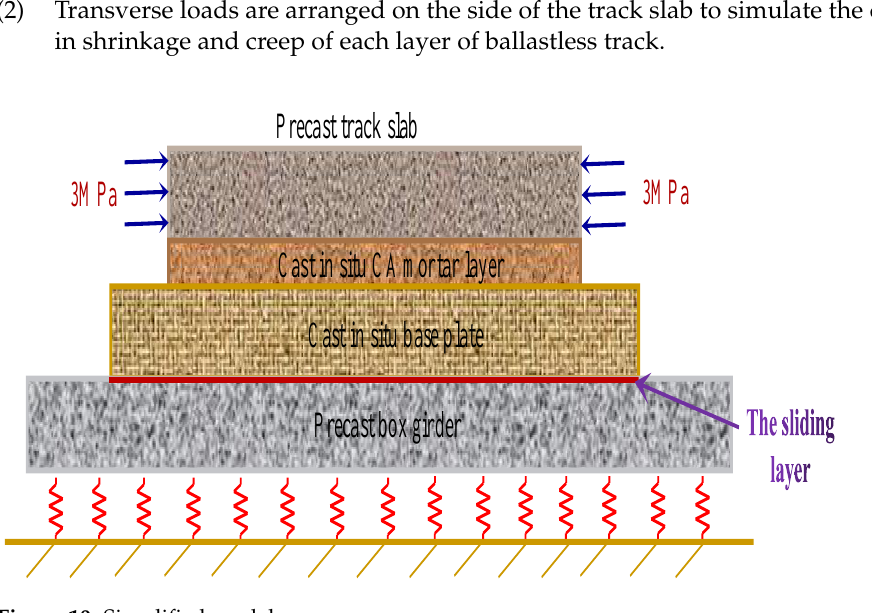
Figure 10. Simplified model.